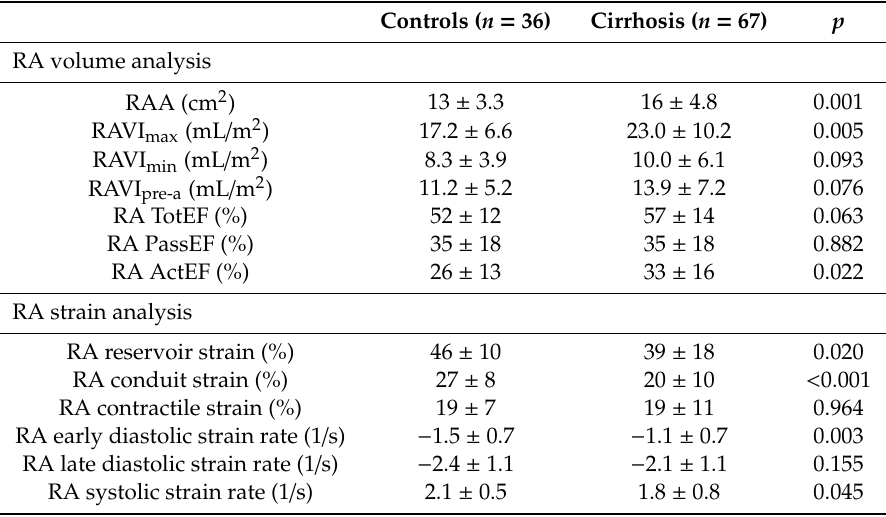
Table 3. Right atrial parameters in the study population.